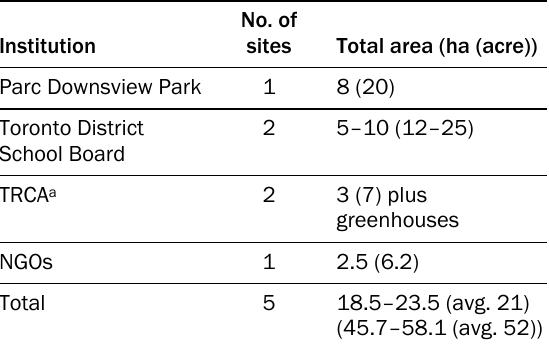
Table 4. Significant Projects Underway or Under Consideration Not Captured by Our